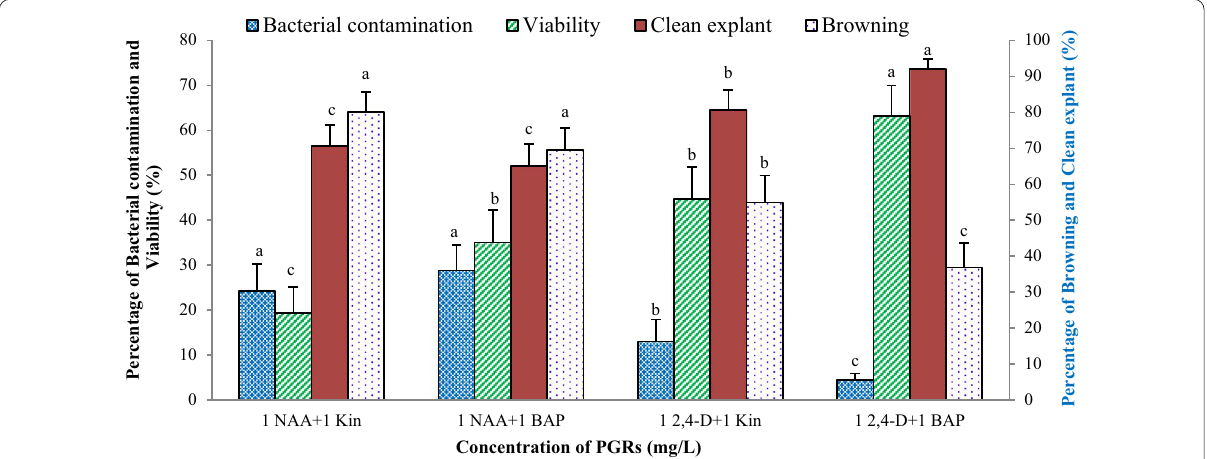
Fig. 1 The effect of plant growth regulators on in vitro responses of M. azedarach L. leaf explants in the culture media containing benomyl (Experiment 2). Bars with different letters indicate a significant difference ( P